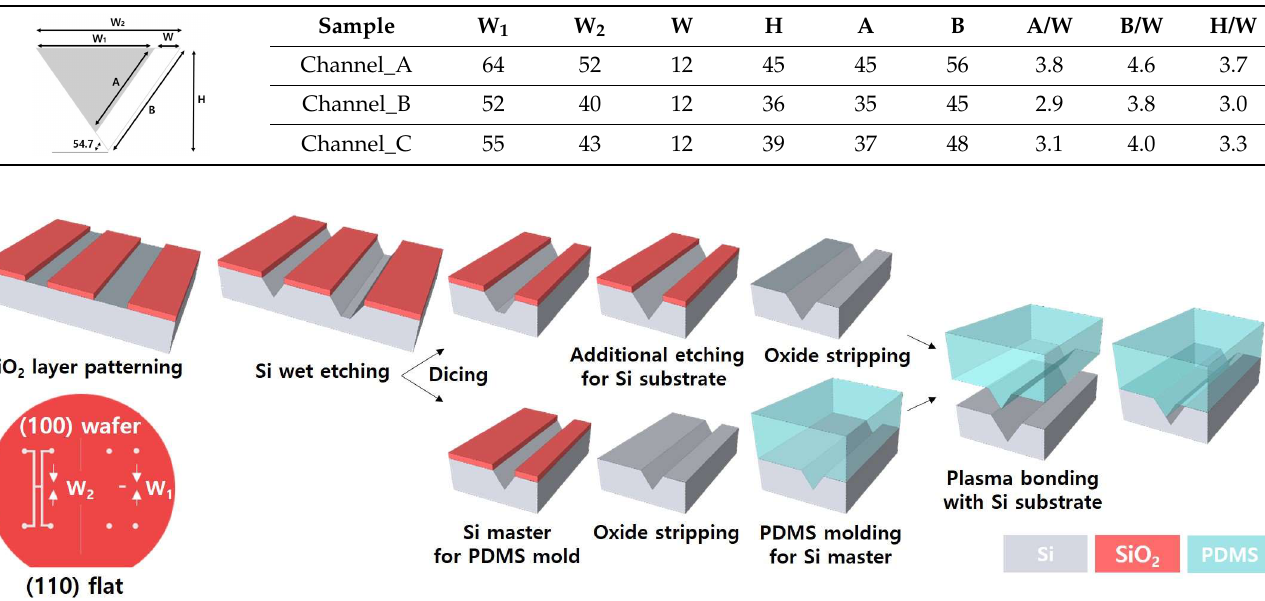
Figure 2. Fabrication process of the microfluidic devices with the asymmetric channel. Table 1. Design parameters of the microfluidic channels with asymmetric cross-sections.